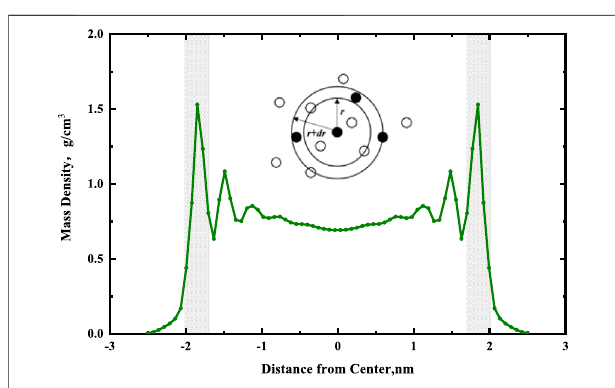
FIGURE 9 | Diagram of the radial distribution function and the region of radial distribution calculation (gray region), black balls represent reference